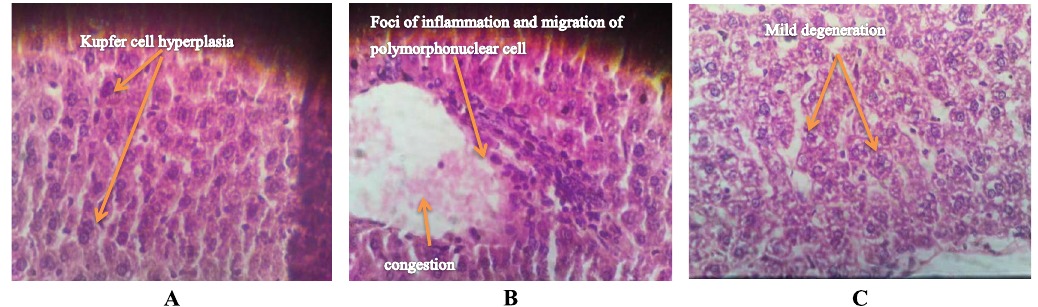
Fig. 5. Cross-liver sections from mice injected intraperitonally with (A , B) capsulated K. ozaenae isolate shows: A: Kupfer cell hyperplasia, B: acute inflammatory cell infiltration (foci of inflammation and migration of polymorphonuclear cell with congestion. C: with non-capsulated K. ozaenae isolate show :mild degeneration (H&E. 200X).